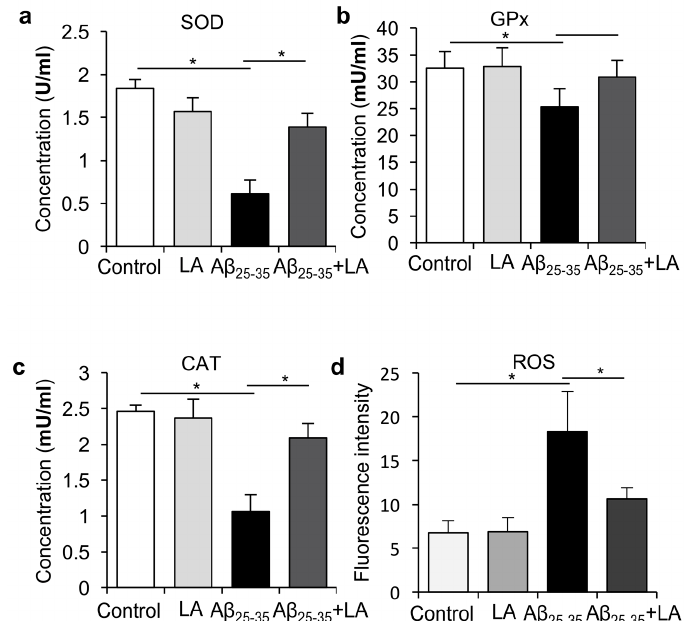
Figure 6. α -lipoic acid (LA) regulated the activity of SOD, GPx, CAT, and ROS in BV2 cells induced by A β 25–35 . ( a – c ) BV2 cells were treated with 25 µ mol/L A β 25–35 , 100 µ mol/L LA, or both for 24 h, and then the activities of SOD ( a ), GPx ( b ), and CAT ( c ) were detected. ( d ) The ROS levels were detected with a fluorescent probe tagged DCFH-DA after BV2 cells were treated with LA and/or A β 25–35 for the indicated time. Values are shown as mean ± SD ( n = 3), * p < 0.05.